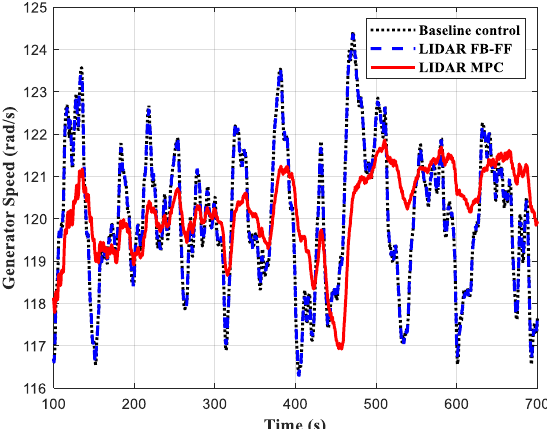
Energies 2022 , 15 , x FOR PEER REVIEW